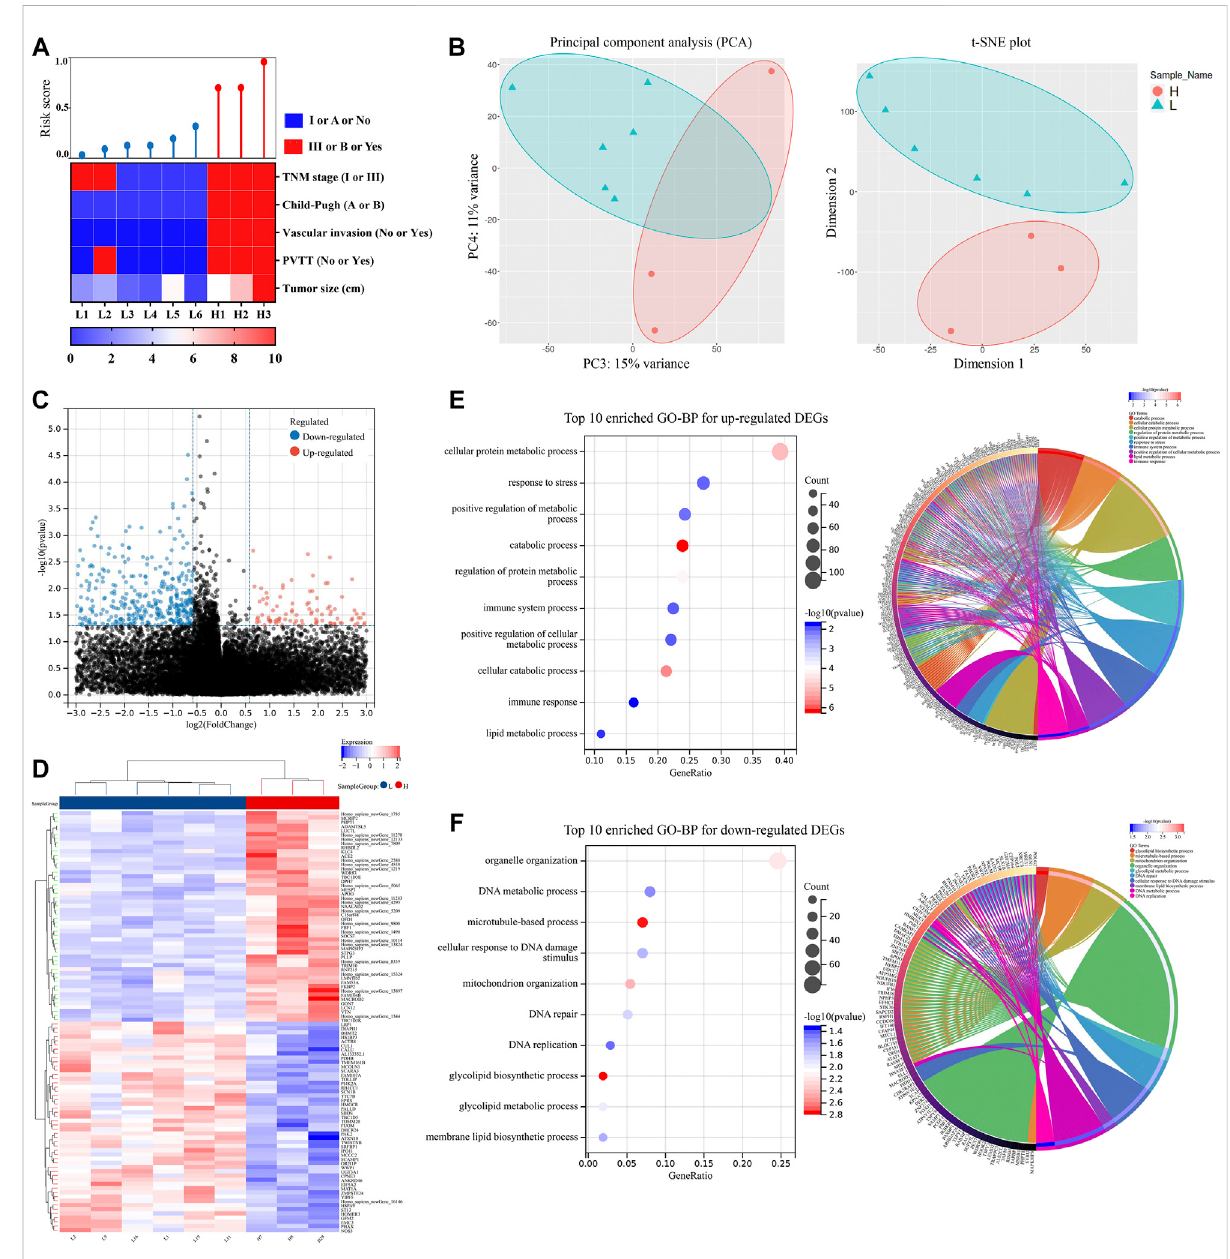
FIGURE 6 Risk score model validation, DEGs screen and potential pathways enrichments using nine HCC samples. (A) Correlations among risk score and clinical characteristics. (B) PCA and t-SNE plot of nine HCC samples. (C) Volcano plot of DEGs. (D) Heat map of DEGs between two groups. (E) Top ten enriched GO-BP and circle plots for up-regulated DEGs. (F) Top ten enriched GO-BP and circle plots for downregulated DEGs. DEGs, differentiallyexpressedgenes;GO,geneontology;BP,biologicalprocess; HCC,hepatocellularcarcinoma; PCA,principalcomponentanalysis; t-SNE, t-distributed Stochastic Neighbor Embedding; TNM, clinicopathological stage; PVTT, portal vein tumor